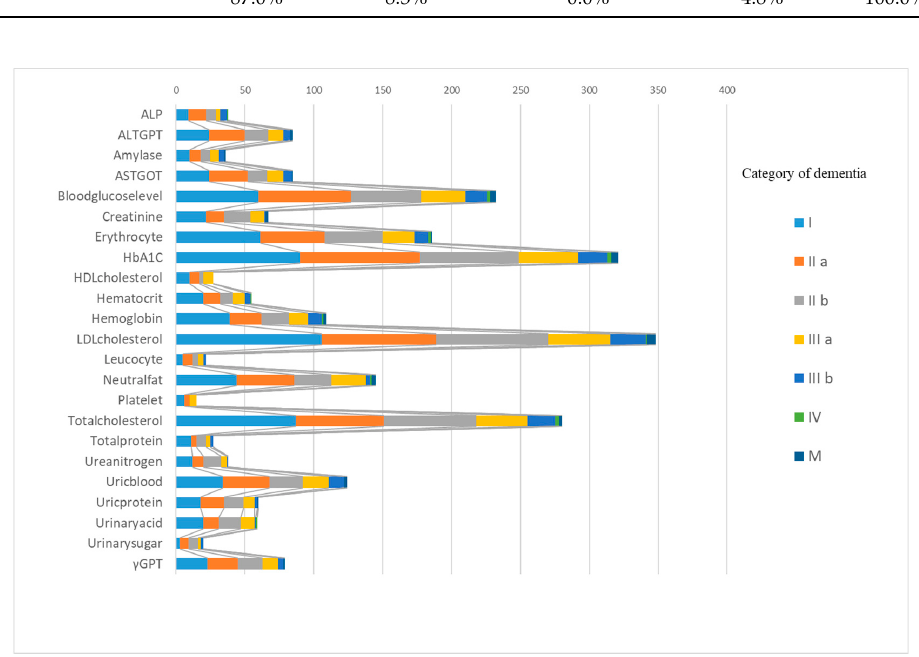
Figure 2. The number of abnormal subjects for each item by the category of dementia.